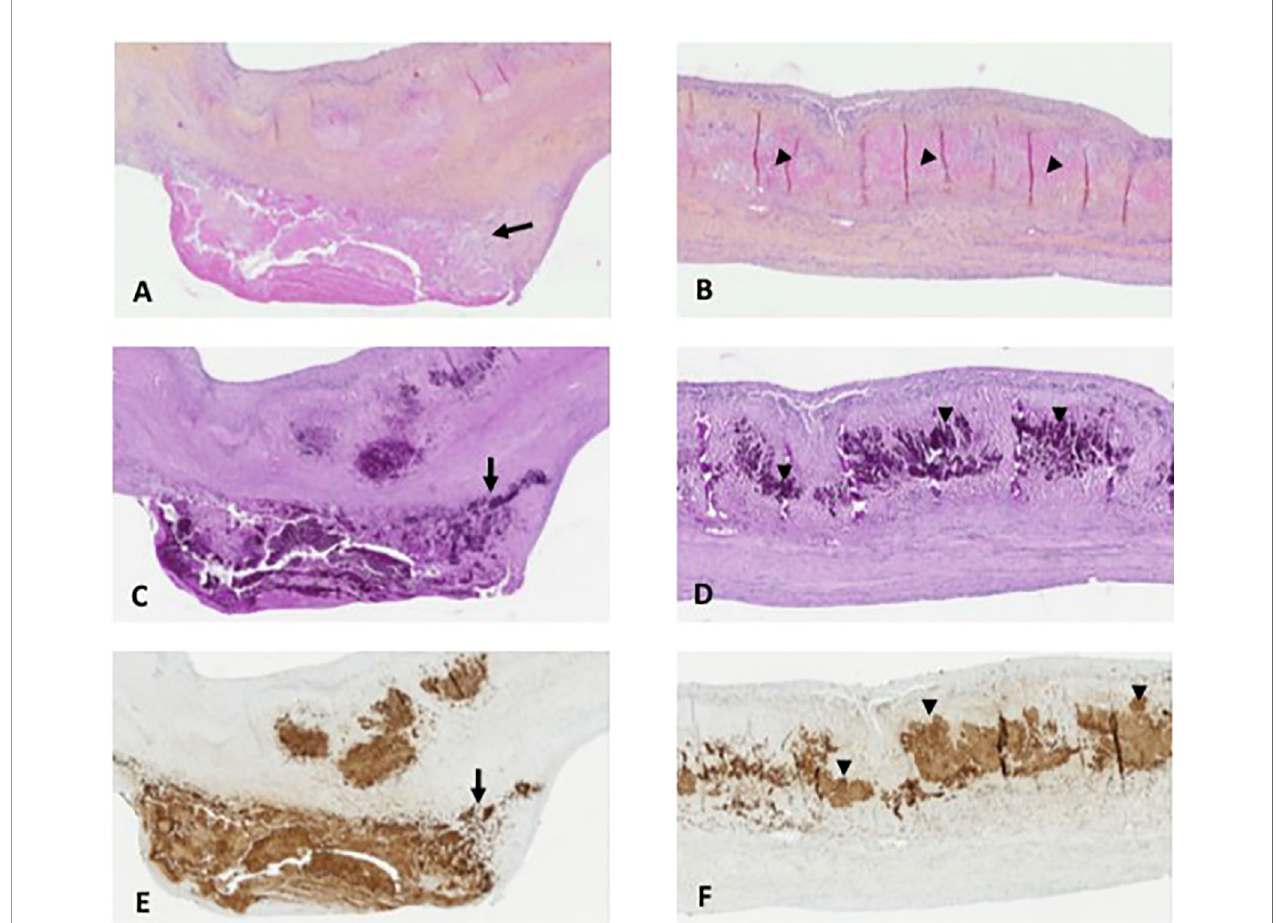
FIGURE 1 | Pathological analysis. (A, B) Aortic valve with Whipple ’ s endocarditis: super fi cial vegetation and fi brosis of the connective valve tissue and mononuclear in fl ammatory cell in fi ltrate with numerous foamy macrophages near the vegetation ( A , arrow) and with large eosinophilic deposits in the connective valve tissue (arrowheads, B ) (hematoxylin – eosin – saffron, original magni fi cation ×100 and ×100, respectively). (C, D) Foamy macrophages containing the characteristic inclusion bodies ( C , arrow) and with massive extracellular detection of bacilli with the PAS stain ( D , arrowheads) (PAS staining, original magni fi cation ×100 and ×100, respectively). (E, F) Immunohistochemical detection of Tropheryma whipplei : bacilli are packed as coarse granular immunopositive material in foamy macrophage cytoplasm ( E , arrow) and in an extracellular location in the connective valve tissue in massive number ( F , arrowheads) (polyclonal rabbit anti- T. whipplei antibody used at a dilution of 1:2,000 with Mayer ’ s hemalum counterstain, original magni fi cation ×100 and ×100,